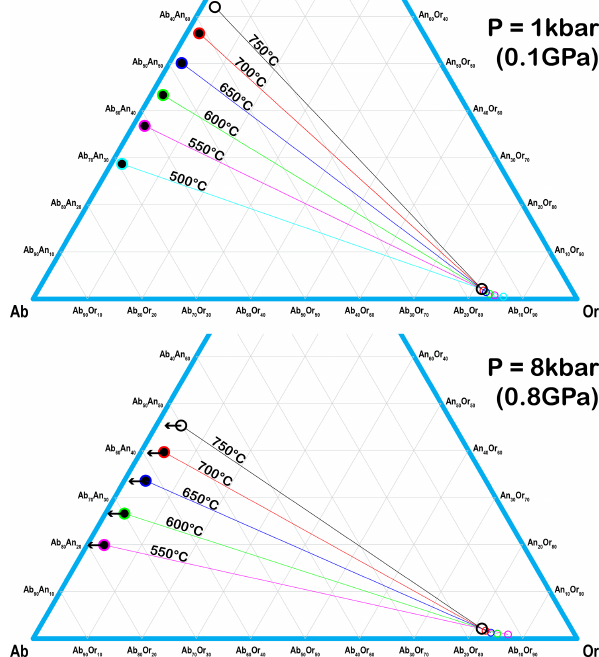
Figure 12. Tie lines that pass through the bulk composition of the RLS at different temperatures under P = 1kbar (0.1GPa) and P = 8kbar (0.8GPa), calculated with SOLVCAL (Wen and Nek- vasil, 1994) using the parameters of Elkins and Grove (1990). The plagioclase end of the tie lines shifts significantly towards sodic compositions at higher